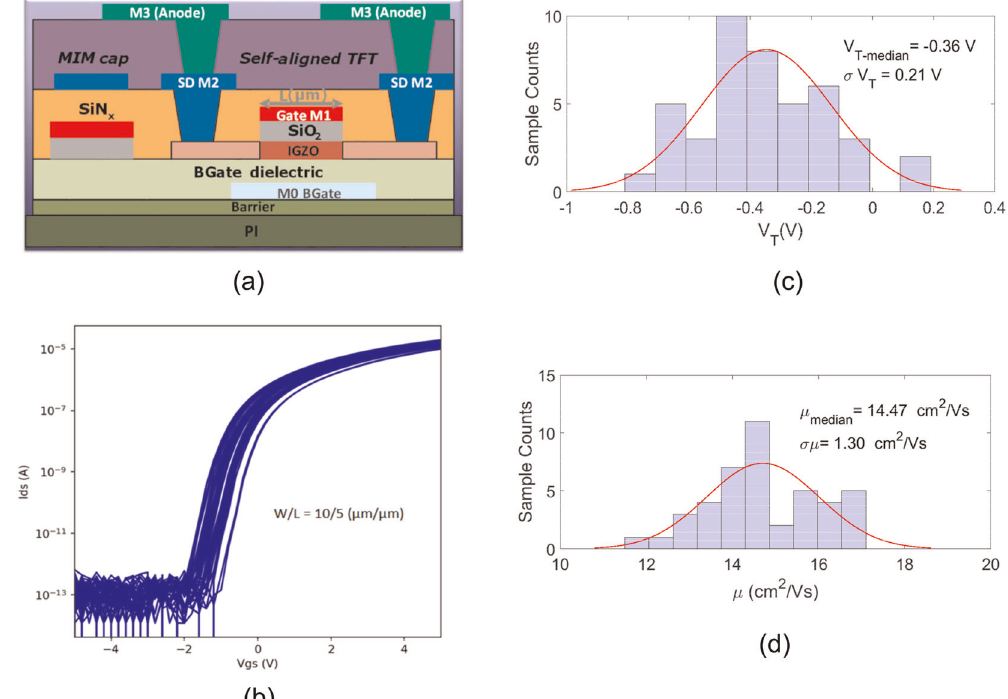
Fig. 6 Device characterization. a TFT cross-sectional view, b Id-Vgs transfer curves of TFTs, c V T distribution and, d Mobility distribution in a sample of 43 test